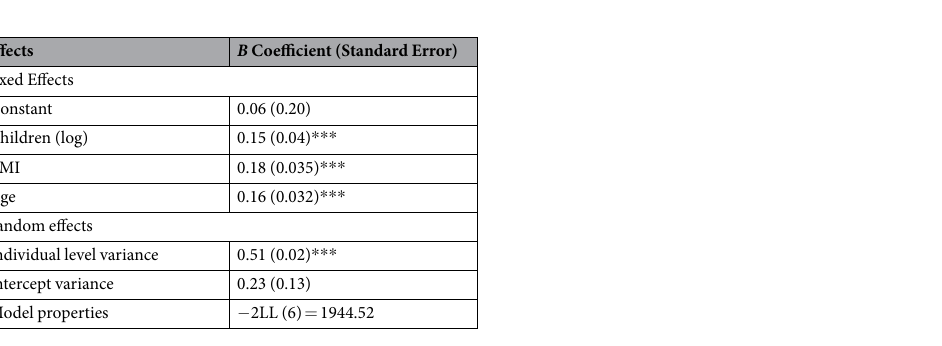
Table 3. Multilevel Regression Model with WHR being predicted by number of children, BMI and Age. Note: *** p <